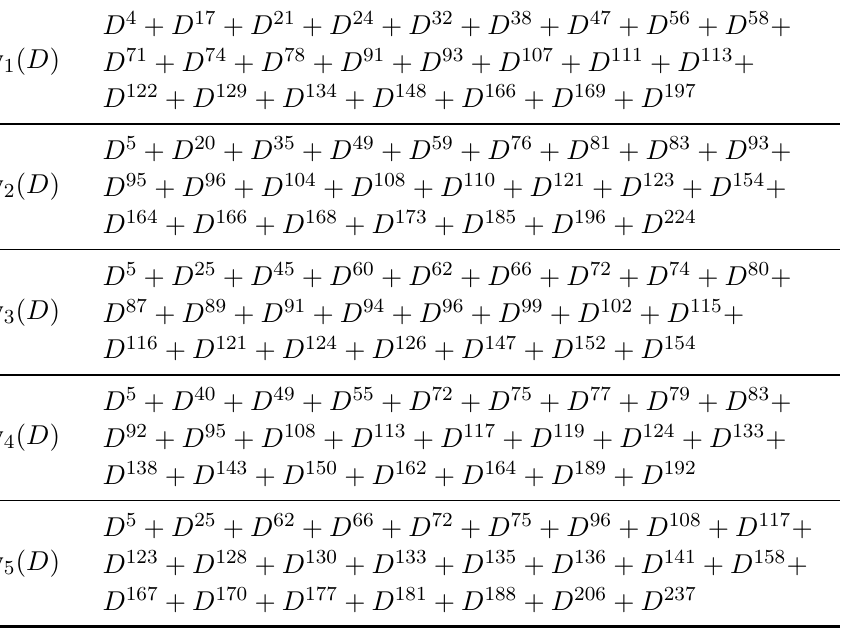
Table 2. The base structured codewords of the (21 , 3 , 5) Tanner